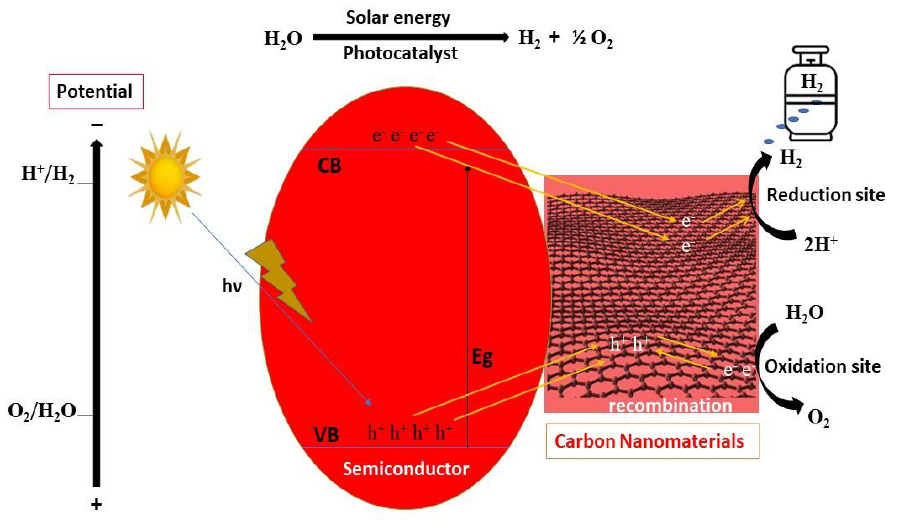
Figure 2. Photocatalytic water-splitting (PWS) mechanism.